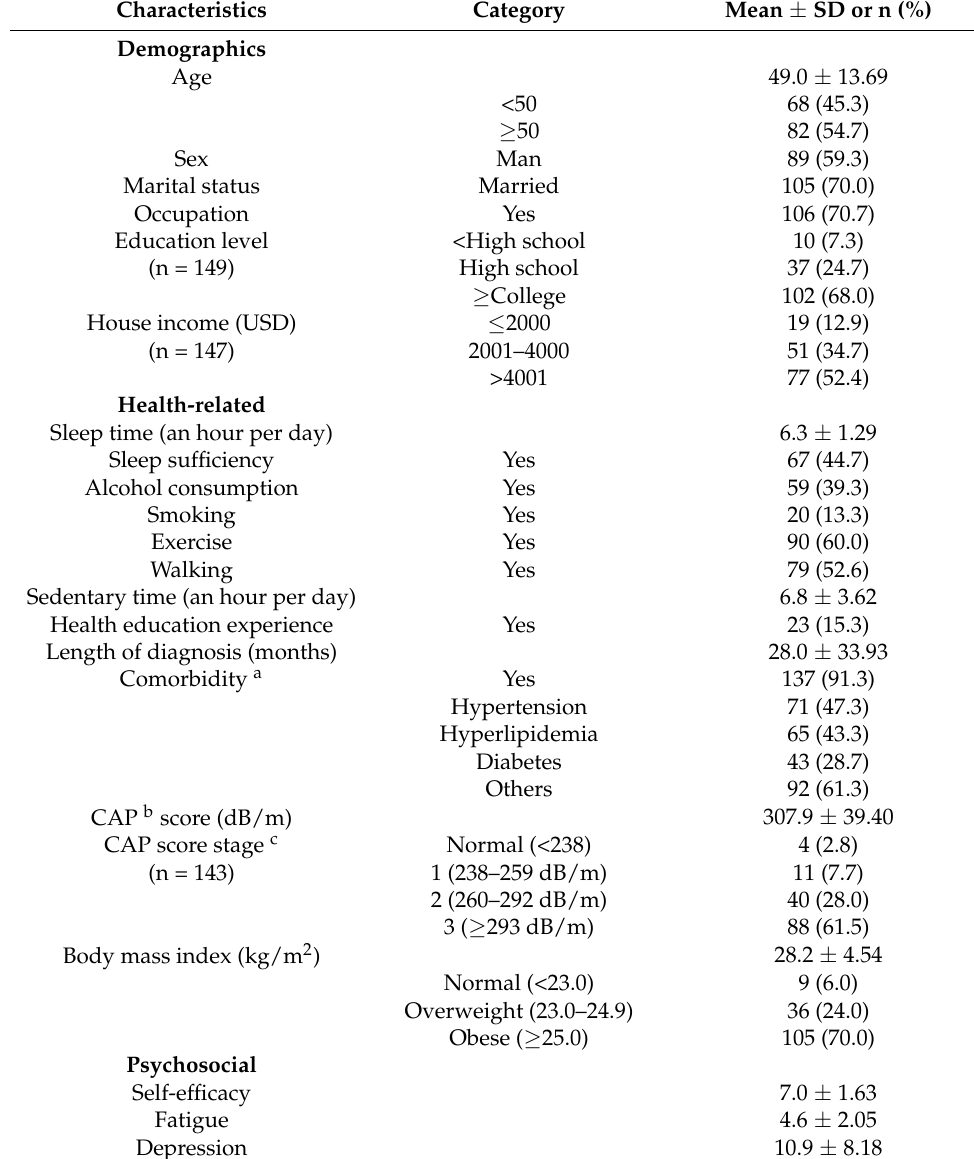
Table 1. Demographic and health-related characteristics of participants ( N =